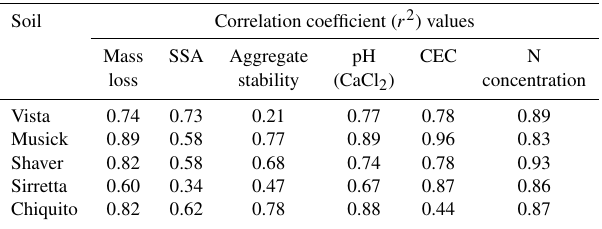
Table 3. Linear correlation coefficients of changes in soil properties with changes in C